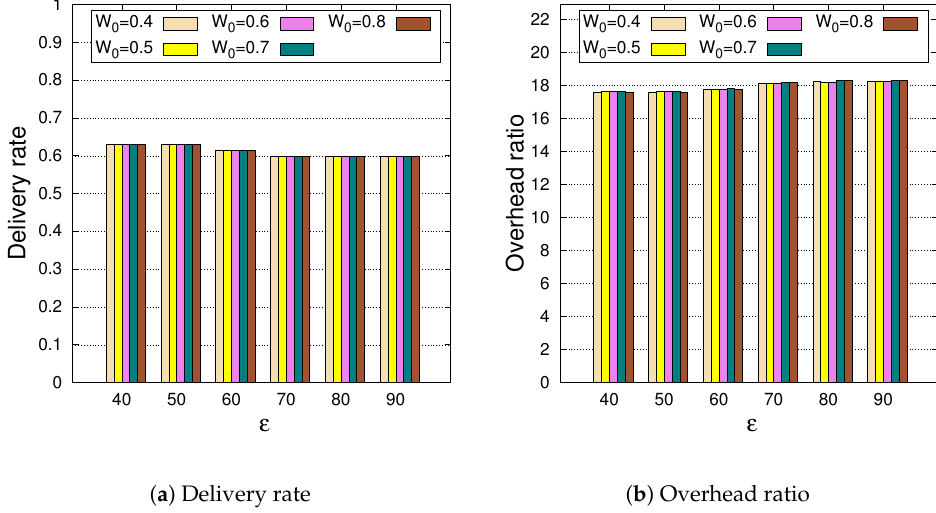
Figure 3. Results by MPMF with different values of (cid:101) and W 0 under TVCM trace (TTL = 5 h and buffer size = 10